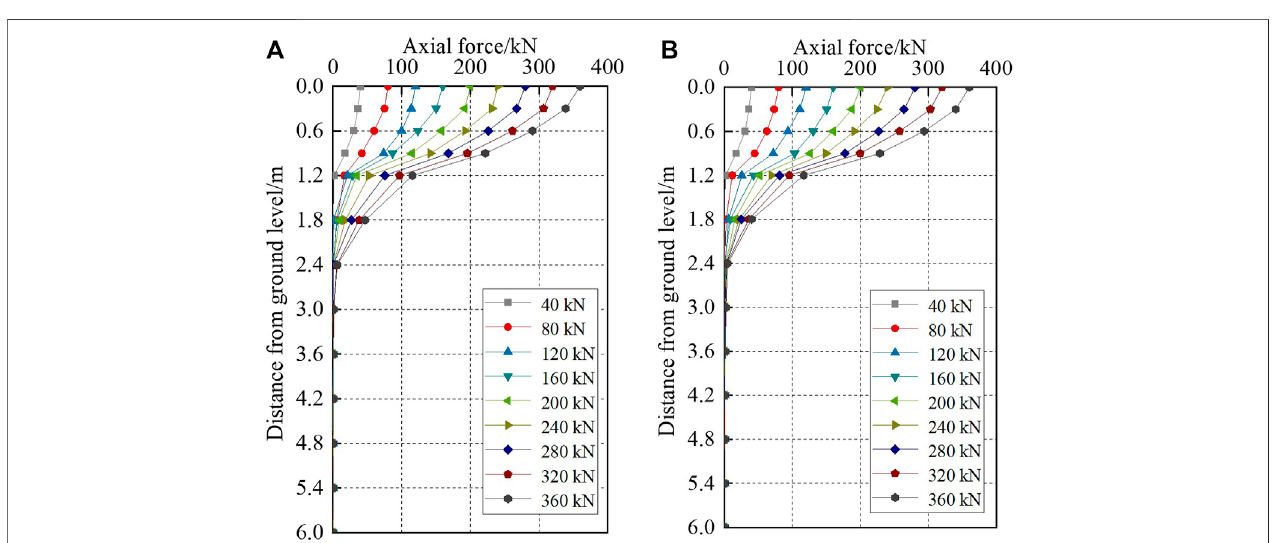
FIGURE 6 | Relationships between the axial force and depth: (A) GFRP1 and (B) GFRP2.